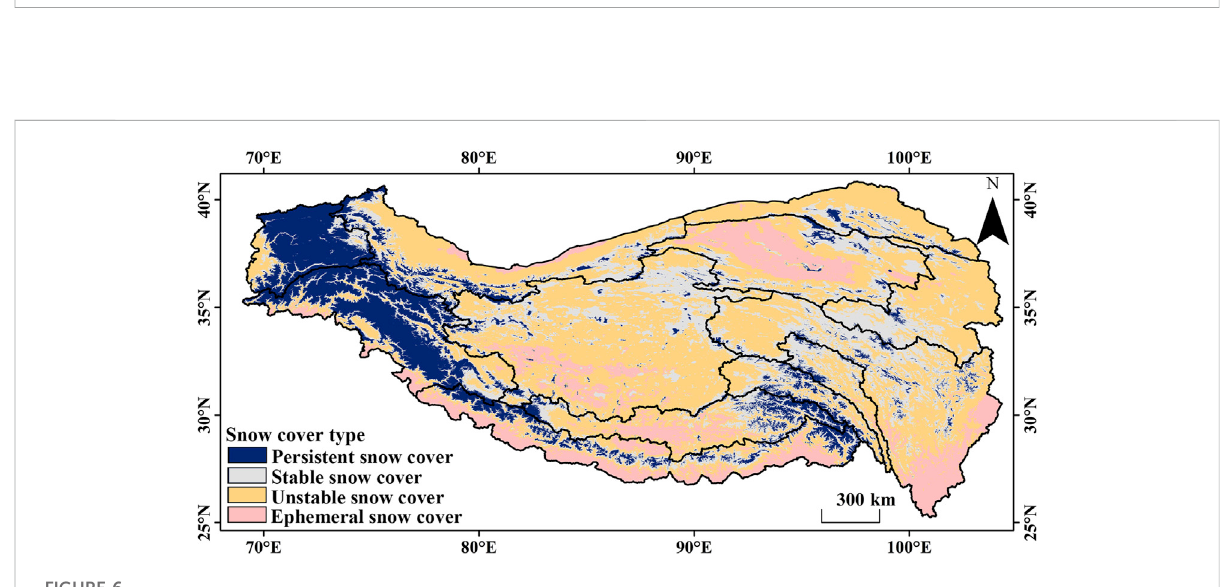
FIGURE 6 Snow cover zoning of the Tibetan